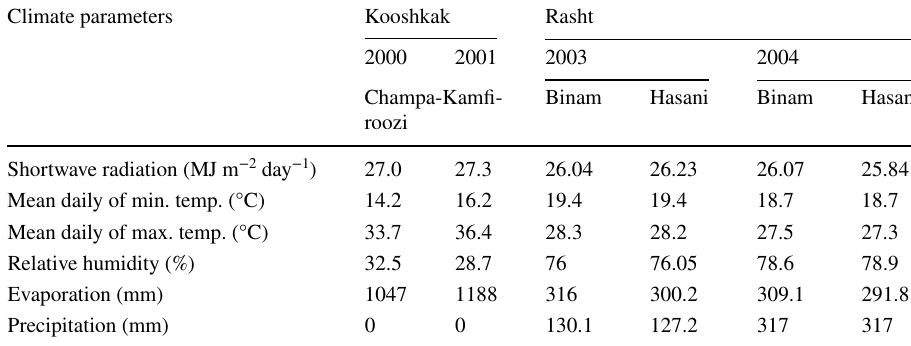
Table 1 Means of climate parameters during growing season for the experimental sites